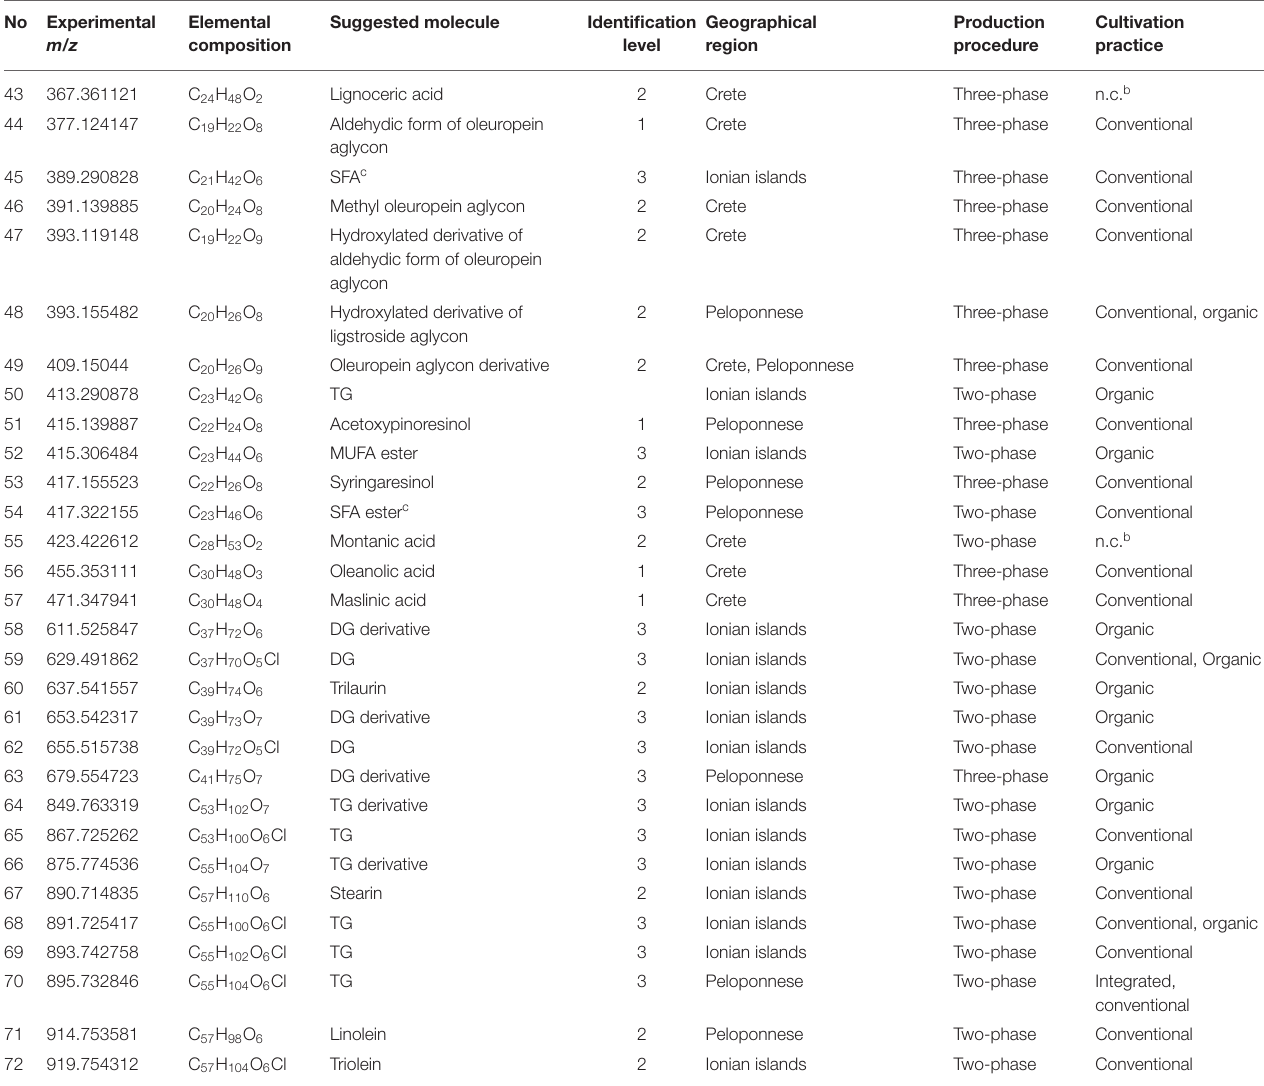
Triolein 2 Ionian islands Two-phase Conventional All the metabolites are numbered according to the first column. Experimental m/z, elemental composition as well as identification level are given. Each metabolite is accompanied with the primary type of classID i.e., geographical region, production procedure, and cultivation practice. a Metabolites marked with “x” are not found in the VIP list for the corresponding quality parameter. b Indication of “n.c.” is referred to features that no conclusion could be made with due to the low number of samples. c SFA, saturated fatty acid; PUFA, polyunsaturated fatty